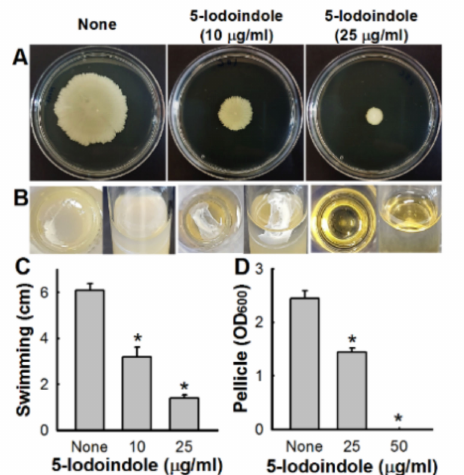
Figure 3. E ff ects of 5-iodoindole on motility and pellicle formation. ( A ) Surface motilities on 0.4% agarose were investigated after adding 5-iodoindole; ( B ) Pellicle inhibition by 5-iodoindole was studied by growing A. baumannii ATCC 17978 strain in the presence or absence of 5-iodoindole for 72 h at 25 ◦ C; ( C , D ) The bar graph represents surface motility diameters (cm) and pellicle formation in the presence or absence of 5-iodoindole. Error bars represent standard deviation. * p < 0.05 versus untreated